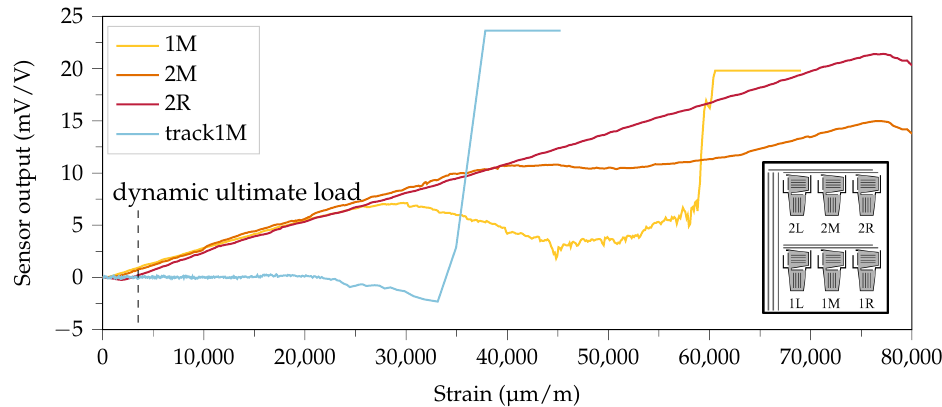
Figure 10. Exemplary sensor signals obtained under tensile load: First row middle sensor element (1M) was the first to deviate from the desired linear elastic characteristic. The middle element in the second row (2M) started decaying at 40,000µmm − 1 . The last of the six sensor elements to loose function was the right element in row two (2R). With a slightly different sample (refer to Section 3.2), the vertical conductive tracks where lengthened, while the sensor signal from sensor element 1M was logged.